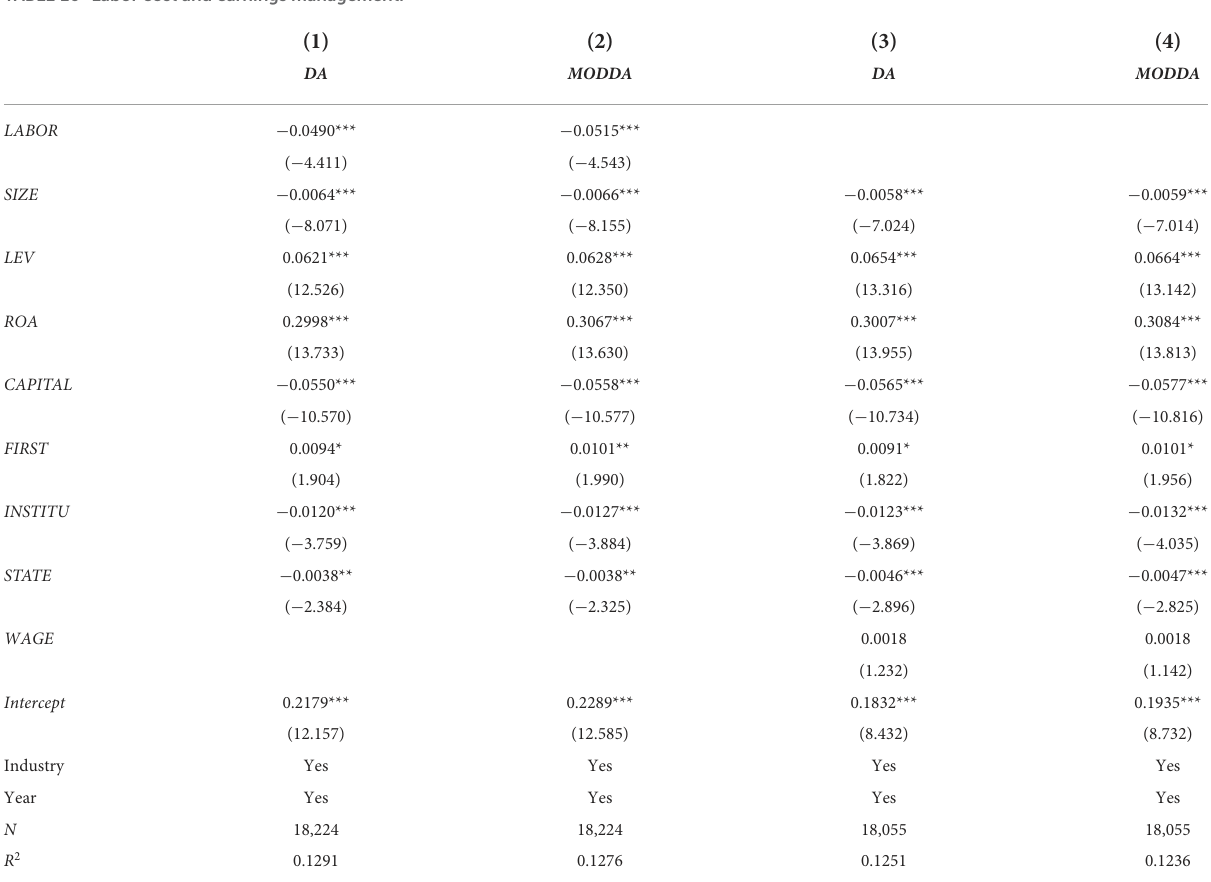
TABLE 10 Labor cost and earnings